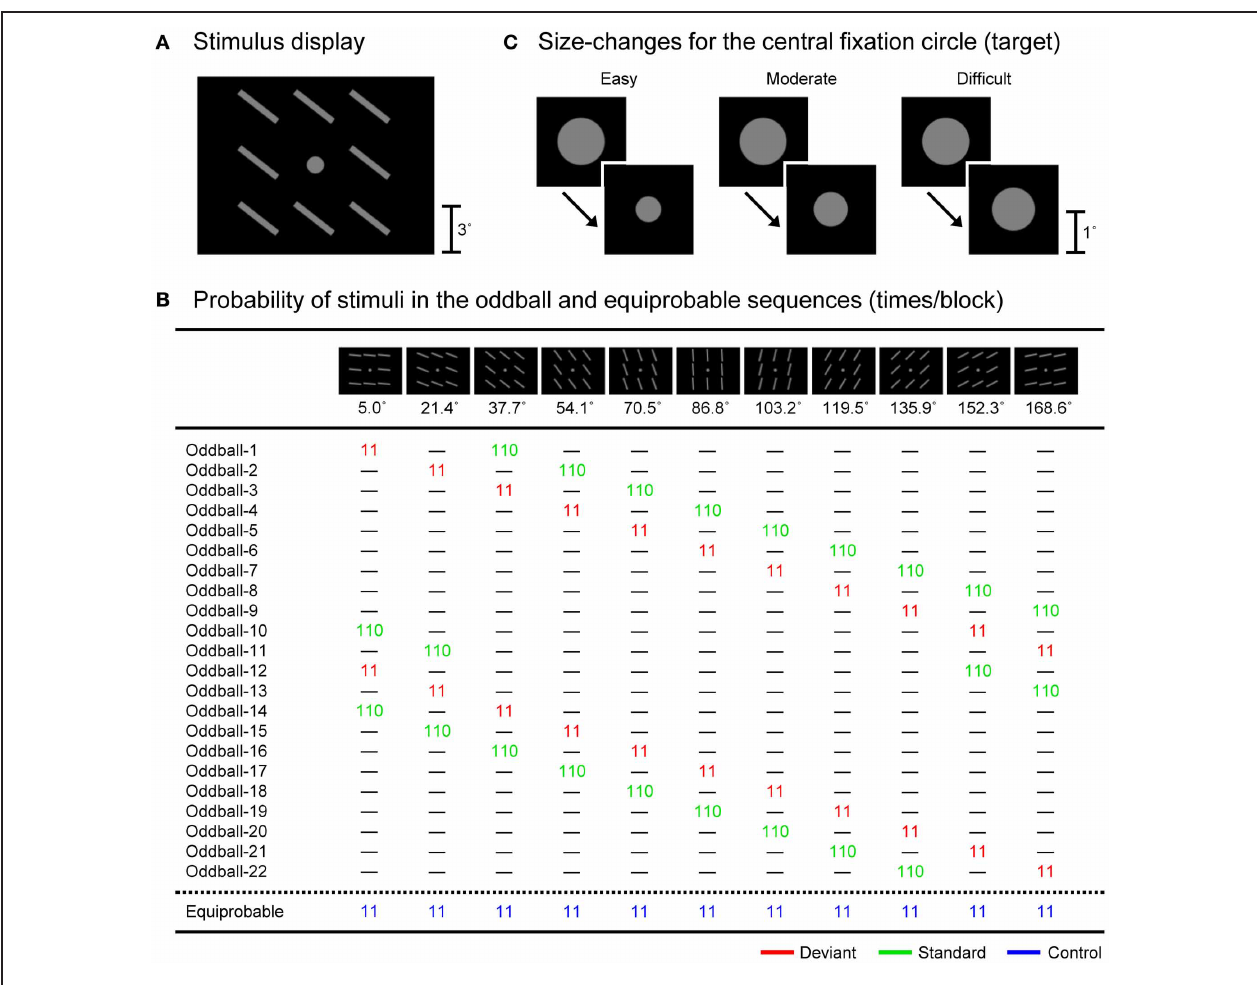
FIGURE 2 | (A) An example of the stimulus display. (B) Stimuli and their probabilities (times/block) in the oddball and equiprobable sequences. (C) Size-changes for the central fixation circle in three task-difficulty conditions (easy, moderate, and